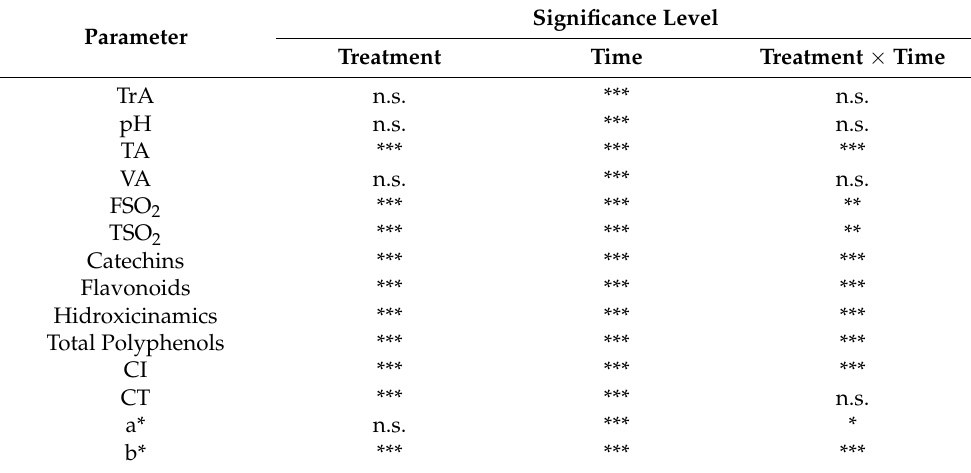
Table 1. Effect of the application of hydrostatic high-pressure (HHP) and maceration with holm oak chips (Treatments). Sampling date (Time) and their interactions on values of chemical parameters in Cayetana